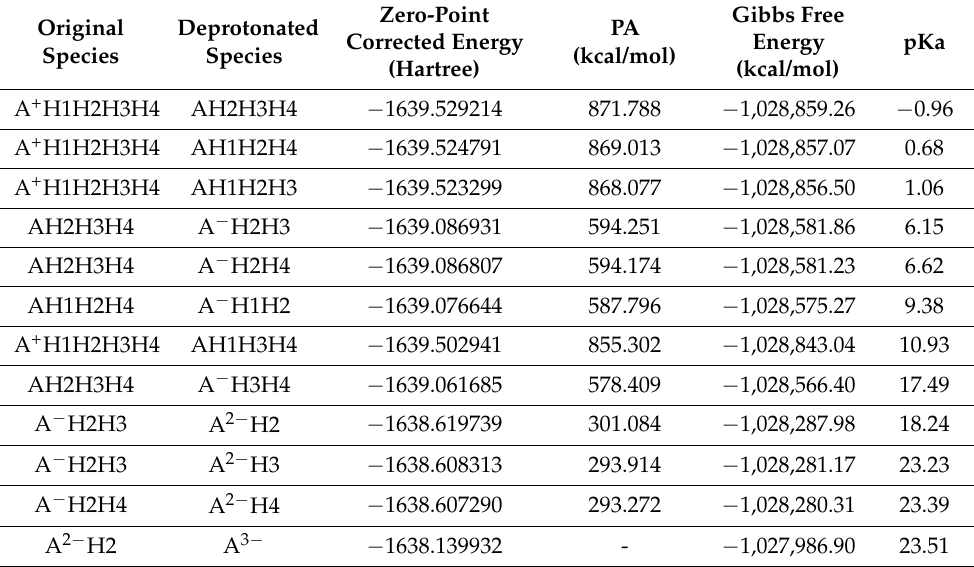
Table 2. Energy, proton affinity (PA), Gibbs free energy, and pKa values of the cyanidin 3-glucoside dye, in various forms of deprotonation. Calculations were performed in water